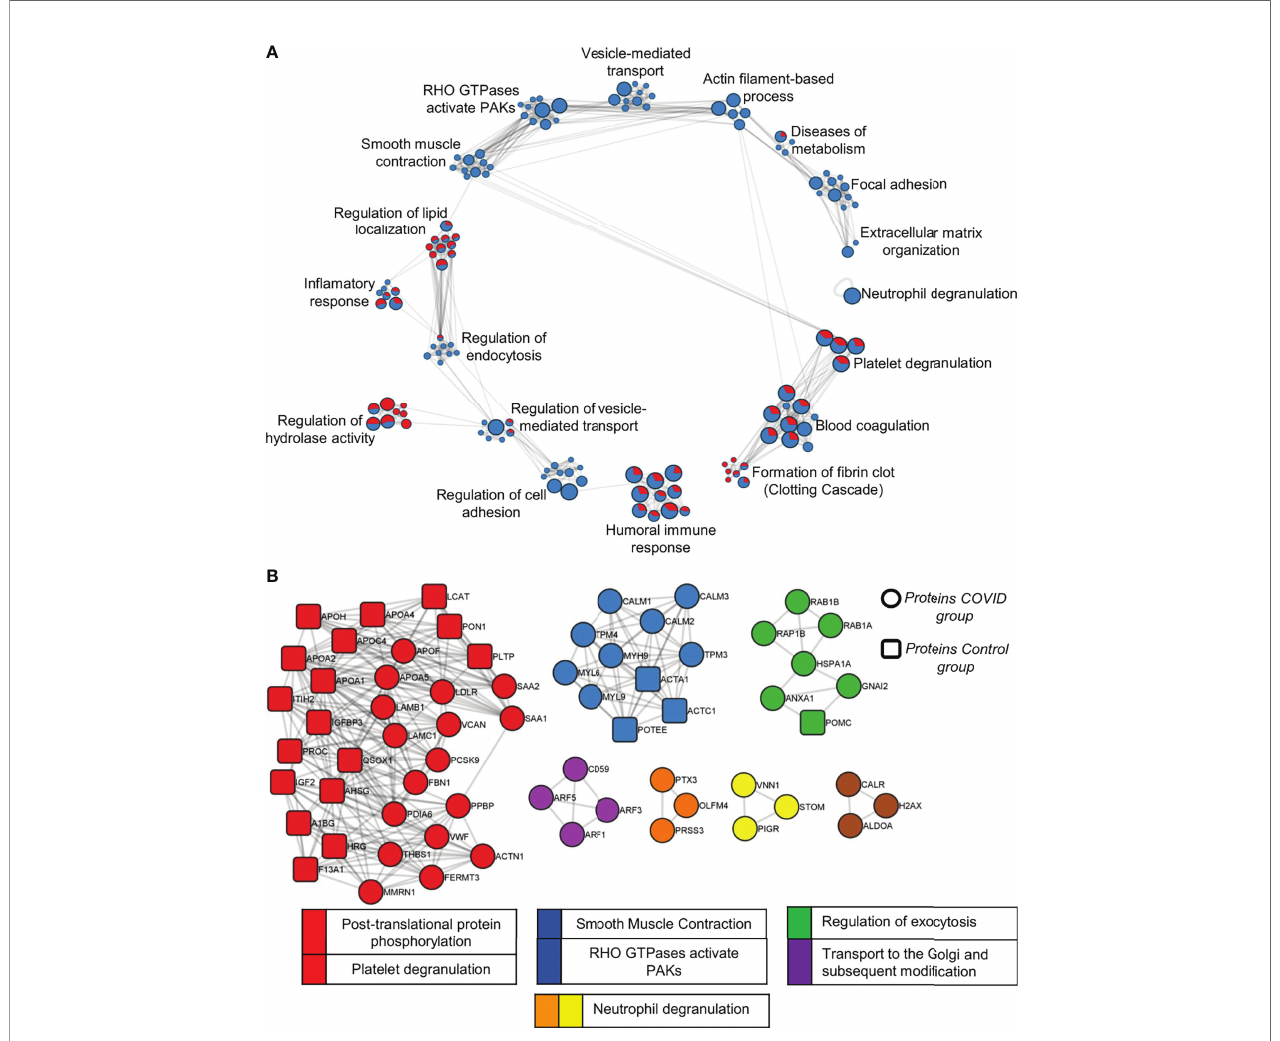
FIGURE 8 | Pathway analysis of C vs COVID-19 proteome. (A) A network of enriched pathway terms from protein lists of DEPs and EPs in the C vs COVID-19 comparison. Nodes that share the same ID are typically close to each other. Pathways database used was WikiPathways, GO Biological Process, KEGG, and Reactome. Red, C; Blue, COVID-12. (B) Protein – protein interaction analysis of DEPs and EPs was performed with STRING, BioGrid, OmniPath, and InWeb_IM databases. Only physical interactions in STRING (physical score >0.132) and BioGrid are